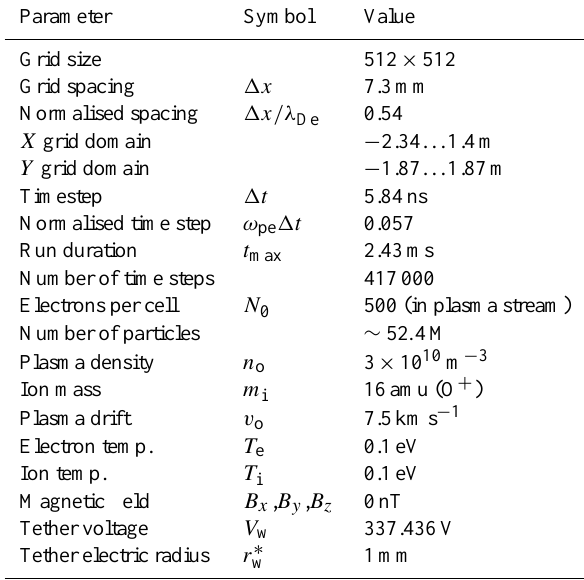
Table 1. Simulation parameters of the V400 run (hereafter referred to as “run